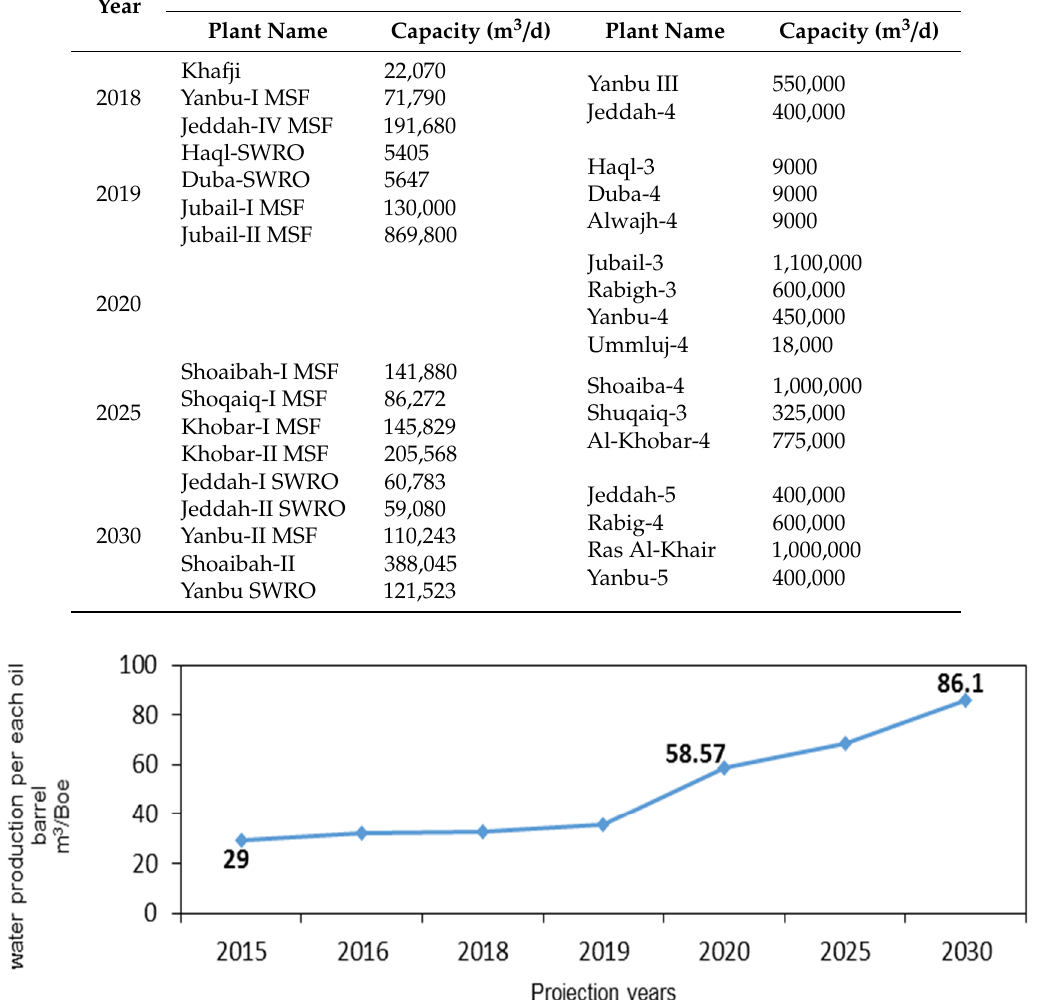
Figure 1. Fuel consumption for water production in the 2030 projection plan.